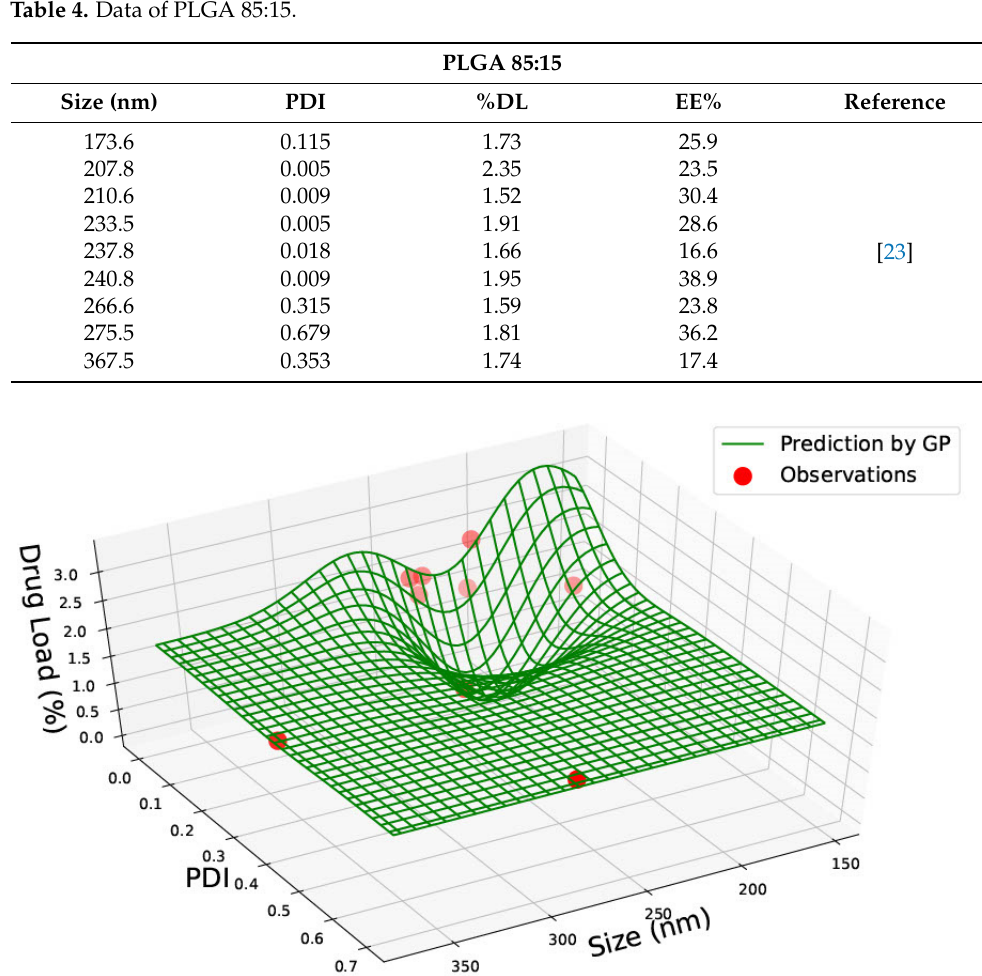
Table 4. Data of PLGA 85:15.